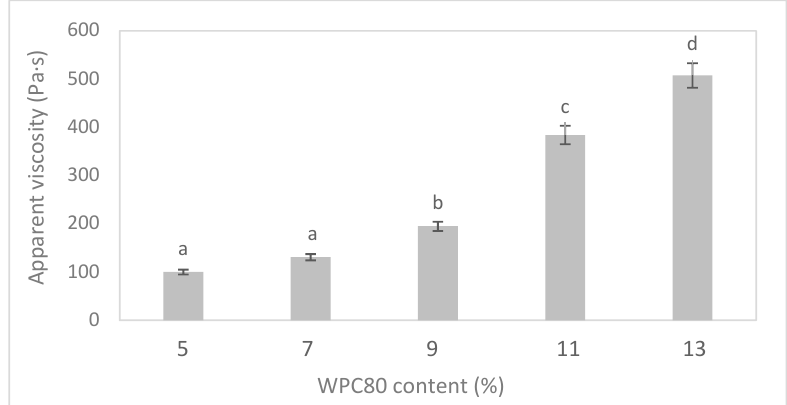
Figure 1. Effect of different WPC80 contents on the apparent viscosity of high-protein fat-free dairy Figure 1. E ff ect of di ff erent WPC80 contents on the apparent viscosity of high-protein fat-free dairy desserts. Letters (a–d) indicate significant differences at p < 0.05 (Tukey’s HSD test). desserts. Letters (a–d) indicate significant di ff erences at p < 0.05 (Tukey’s HSD test).